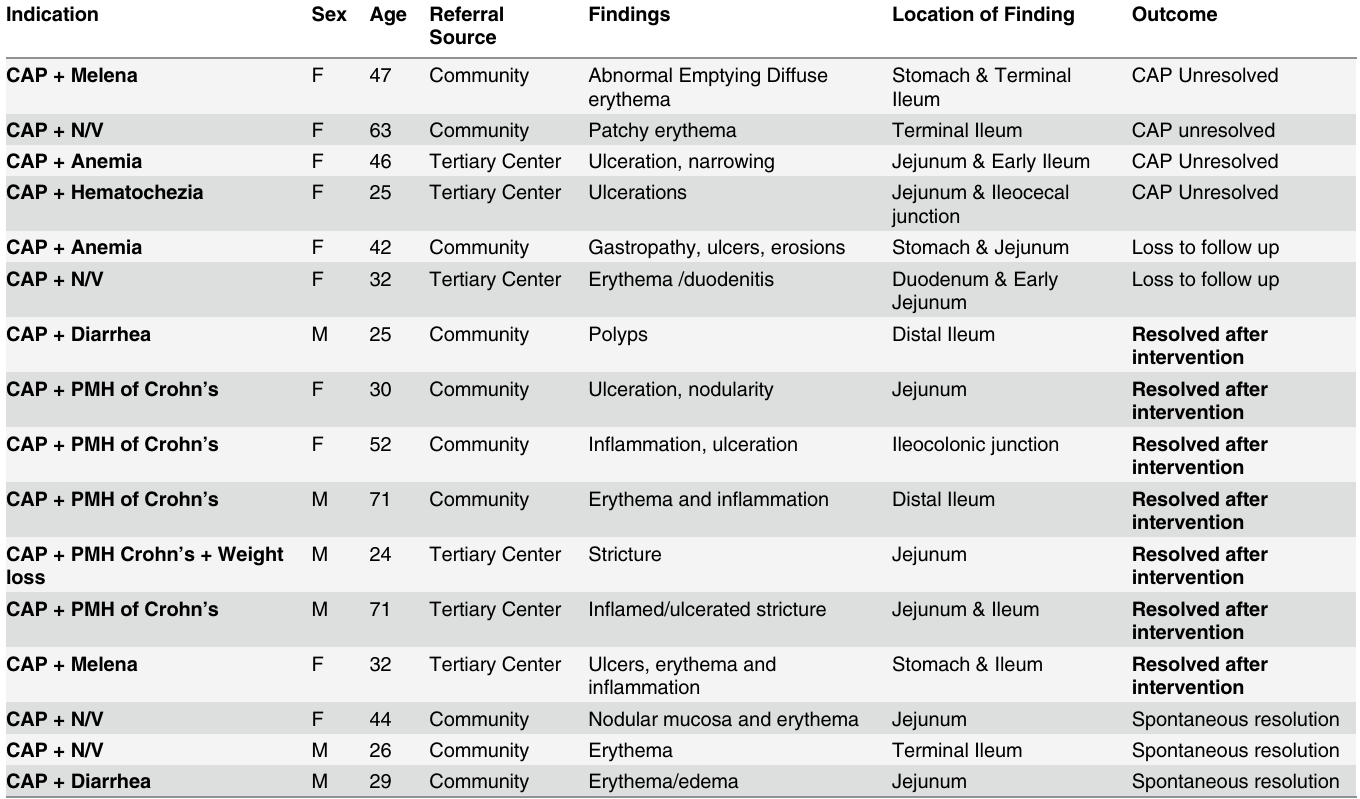
Table 3. Abnormal findings and outcomes for CAP-A patients.